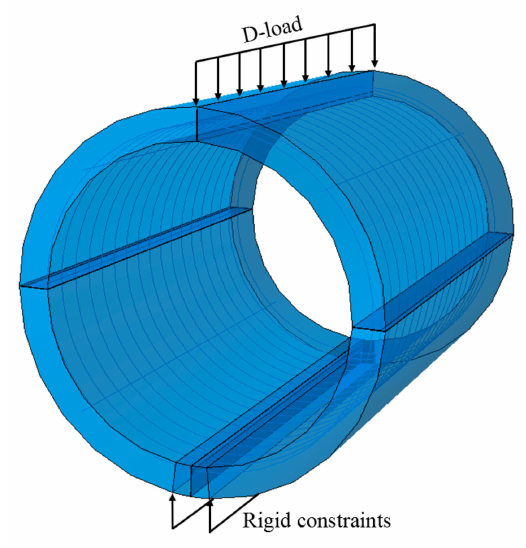
Figure 6. Boundary and loading conditions of the FEM model.